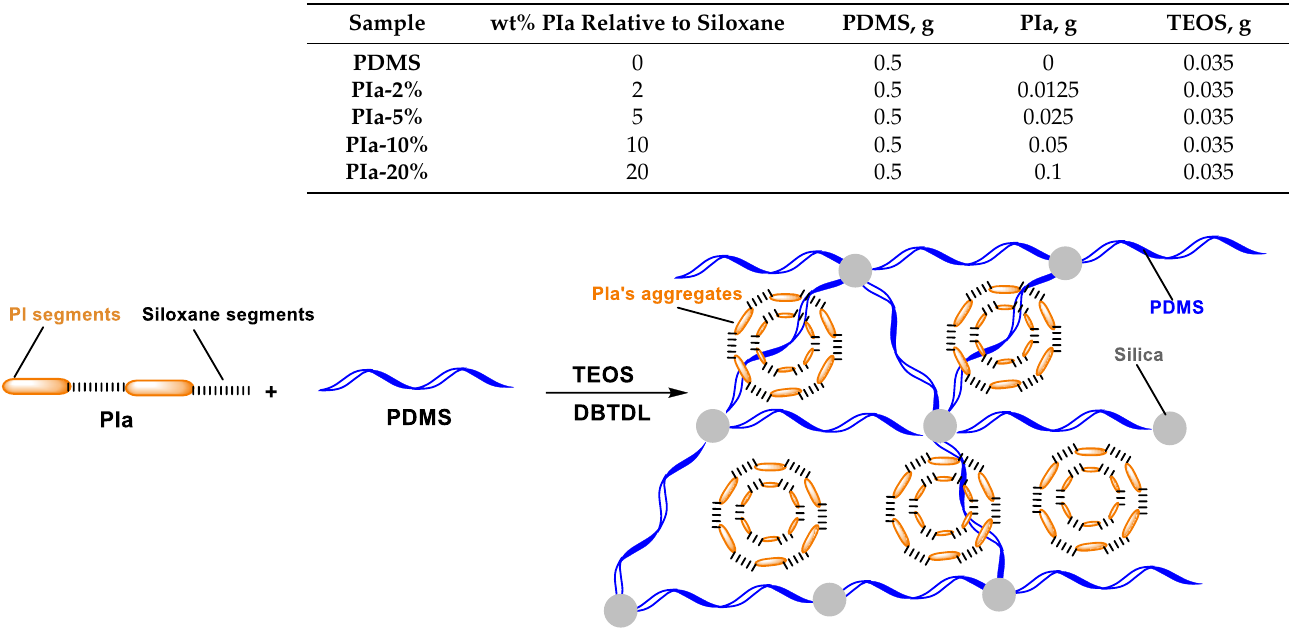
Table 1. Composition of the samples